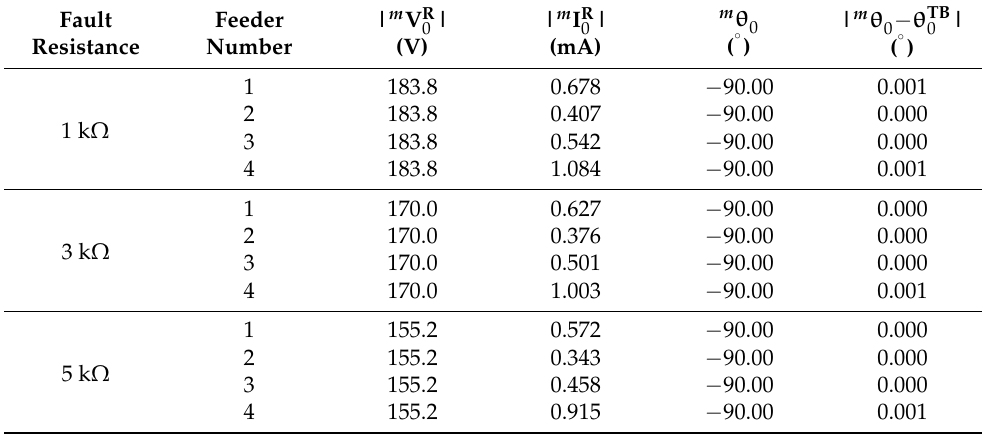
Figure 14. GOOSE messages sent when an SLG fault developed in the busbar with a fault resistance of 3 k Ω . Table 3. Test results for SLG busbar faults with various resistances.